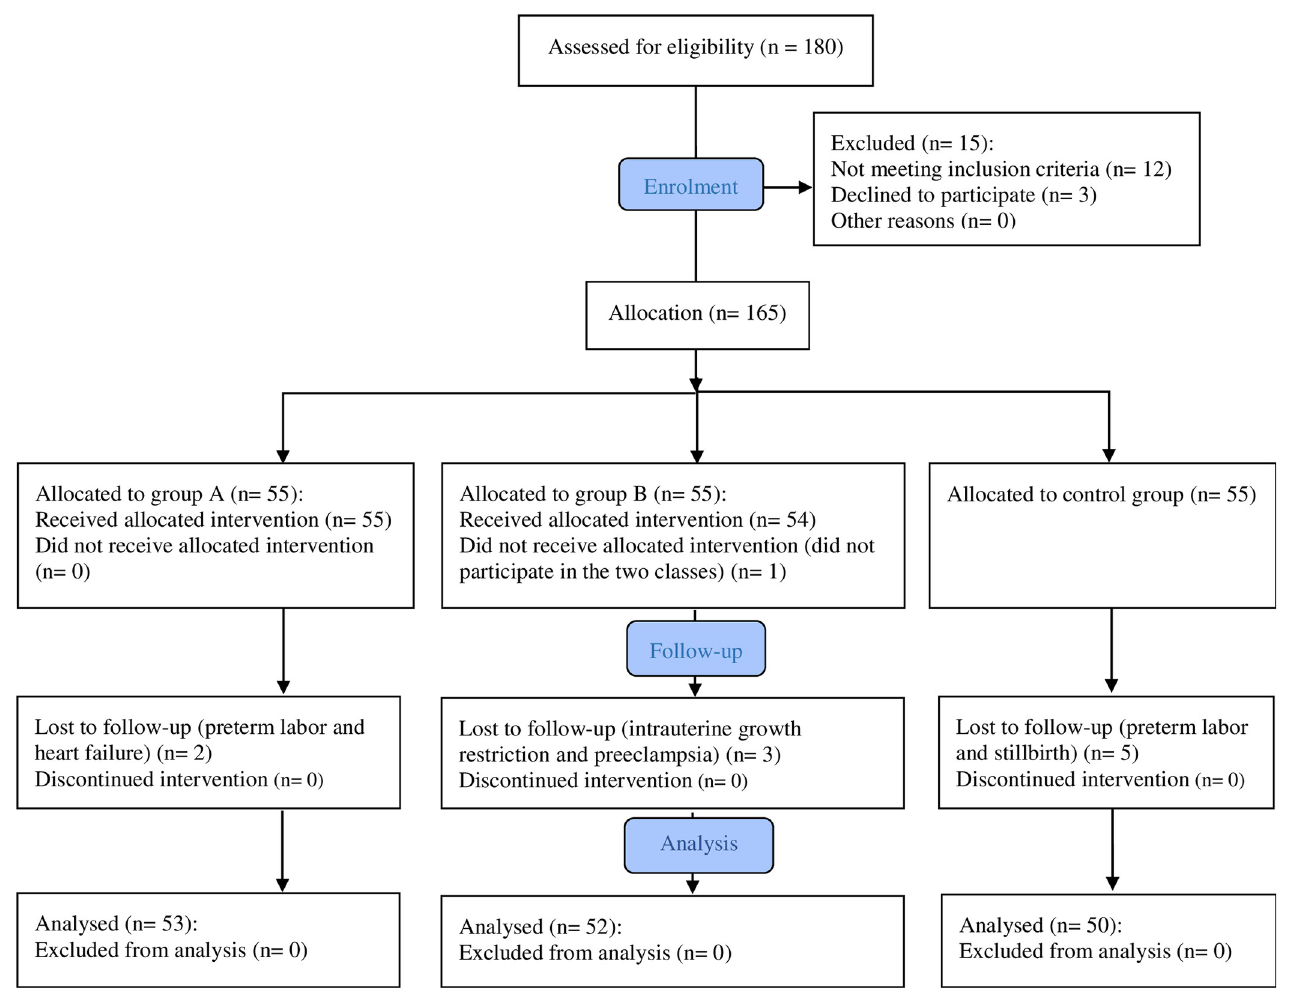
Fig 1. Flowchart of the recruitment process for